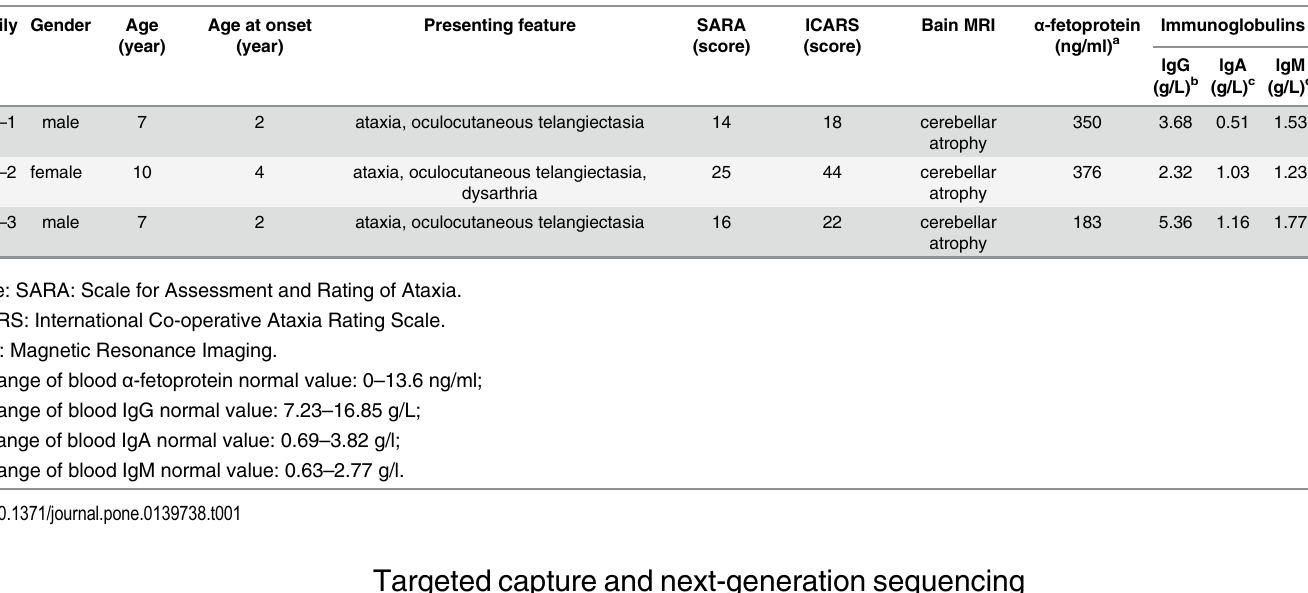
Genomic DNA was extracted from peripheral blood leukocytes by standard methods. The qualified genomic DNA sample was randomly fragmented by ultrasonoscope (Covaris S2, Massachusetts, USA) and the size of the library fragments was mainly distributed between 200 to 250bp. Next, purified DNA was treated with T4 DNA polymerase, T4 phosphonucleotide kinase and the Klenow fragment of Escherichia coli DNA polymerase to fill 5' overhangs and remove 3' overhangs. Terminal A residues were added following the incubation with dATP and the Klenow 3'-5' exo-enzyme by standard Illumina protocols. Then adapters were ligated to both ends of the resulting fragments.